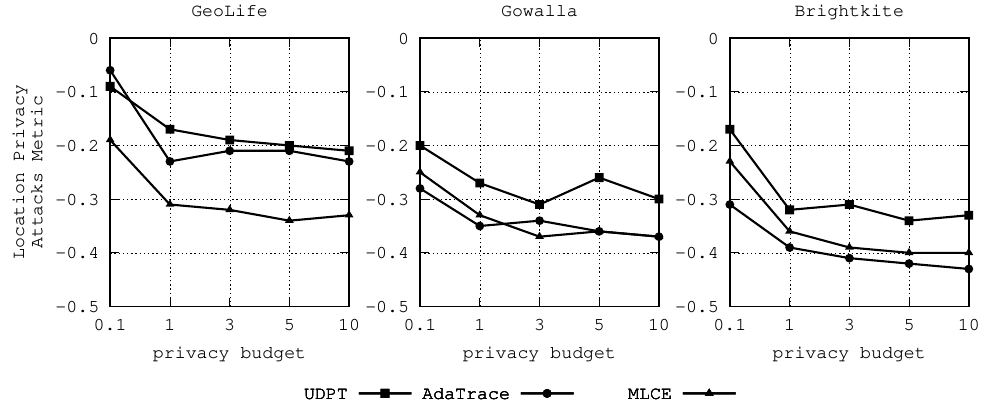
Figure 5. Comparison of UDPT against existing location privacy protection algorithms in terms of location privacy attacks metric under different privacy budgets on three datasets. A larger ordinate indicates a stronger prevention from